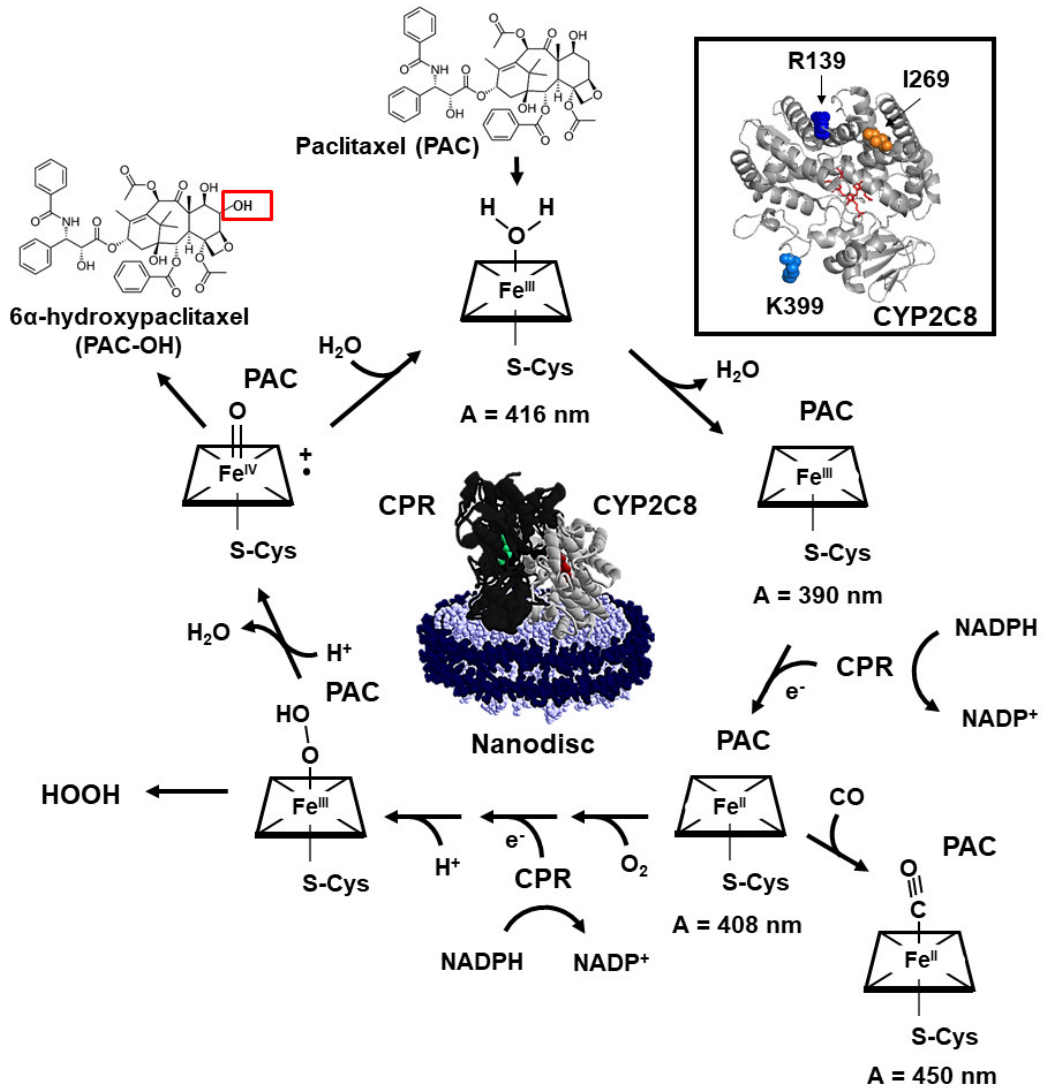
Figure 1. Schematic of the CYP catalytic cycle. Inset shows the structure of CYP2C8 with residues R139 (blue), I269 (orange), and K399 (light blue) highlighted. Structure was generated in PyMol v1.3r1 using the PDB entry 1PQ2. A schematic of CYP2C8 (grey) and CPR (black) incorporated into nanodiscs is shown in the center of the cycles. Catalytic cycle . Substrate (PAC) binds to the CYP active site, which perturbs the H 2 O coordination to the iron heme. H 2 O unbinds leaving a pentacoordinated high-spin iron heme. CPR reduces the iron heme using an electron obtained from NADPH. Under anaerobic conditions, CO ligates the heme to terminate the cycle. Under aerobic conditions, O 2 ligates the heme, followed by another one-electron reduction by CPR and the addition of a proton to produce a peroxy-heme. The peroxy-heme can decompose forming HOOH or eliminate an H 2 O molecule to produce the catalytic ferryl iron heme radical (Compound I). Compound I can oxidize substrate (PAC) to product (PAC-OH, red box), followed by the coordination of an H 2 O molecule to begin the cycle again. Spectroscopically visible species are indicated with their characteristic absorbance wavelength. More details of the cycle can be found in previous reviews